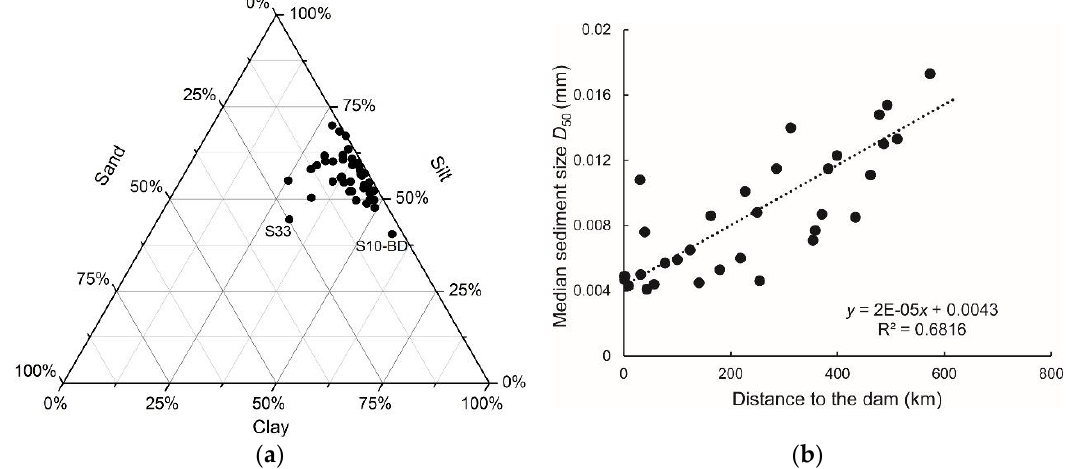
Figure 2. ( a ) Textural composition of the surface sediment samples in the Three Gorges Reservoir (triangle diagram), and ( b ) the variation of median sediment size D 50 with the distance to the dam.